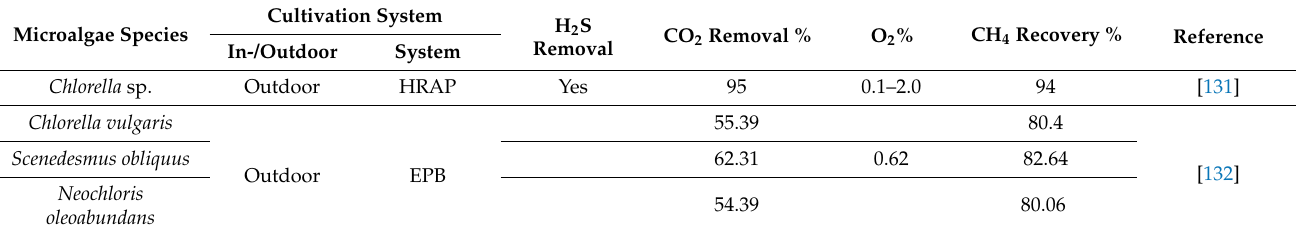
Table 6. Potential of different microalgae species for biogas upgrading